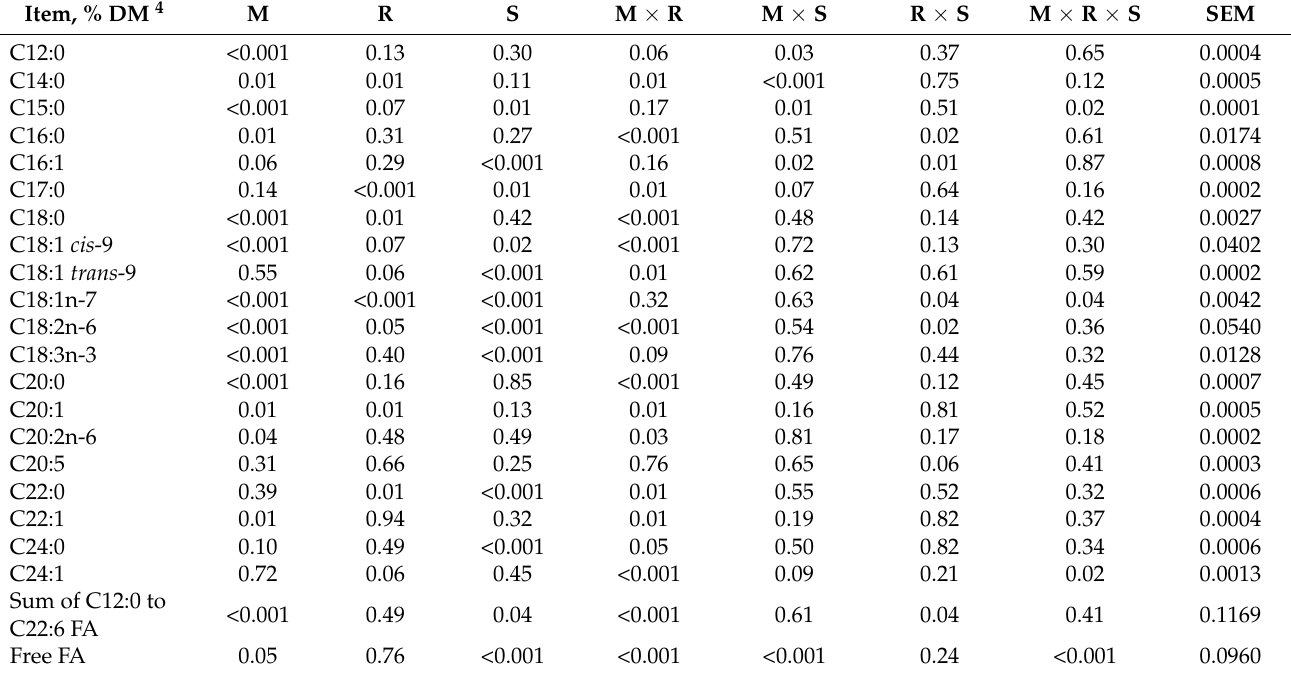
Table 4. Statistical analysis ( p -values) for the effect of maturity 1 (M), roll gap width 2 (R), storage length 3 (S), and their interactions on the fatty acid profile of whole-plant maize silage. (total n =